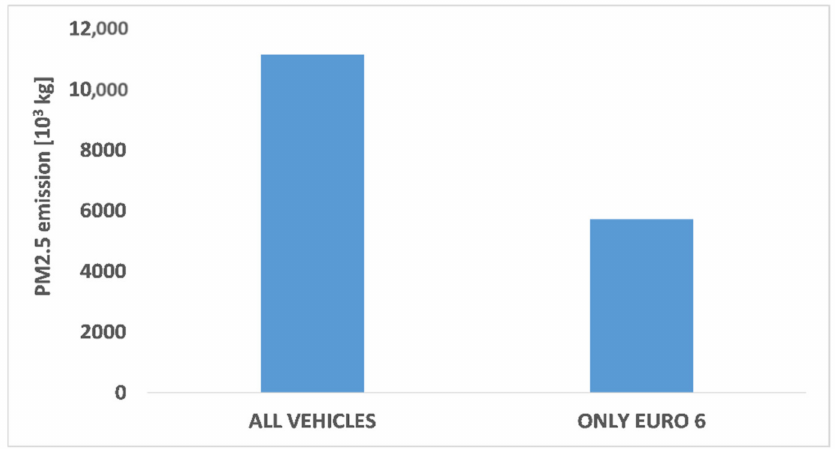
Figure 18. Comparison of PM2.5 emissions from all vehicles and Euro 6 vehicles